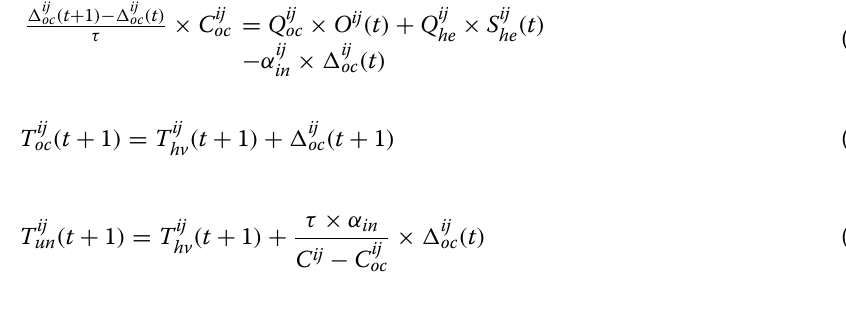
Table 3 Notations used in the revised thermal model Symbol Description Default